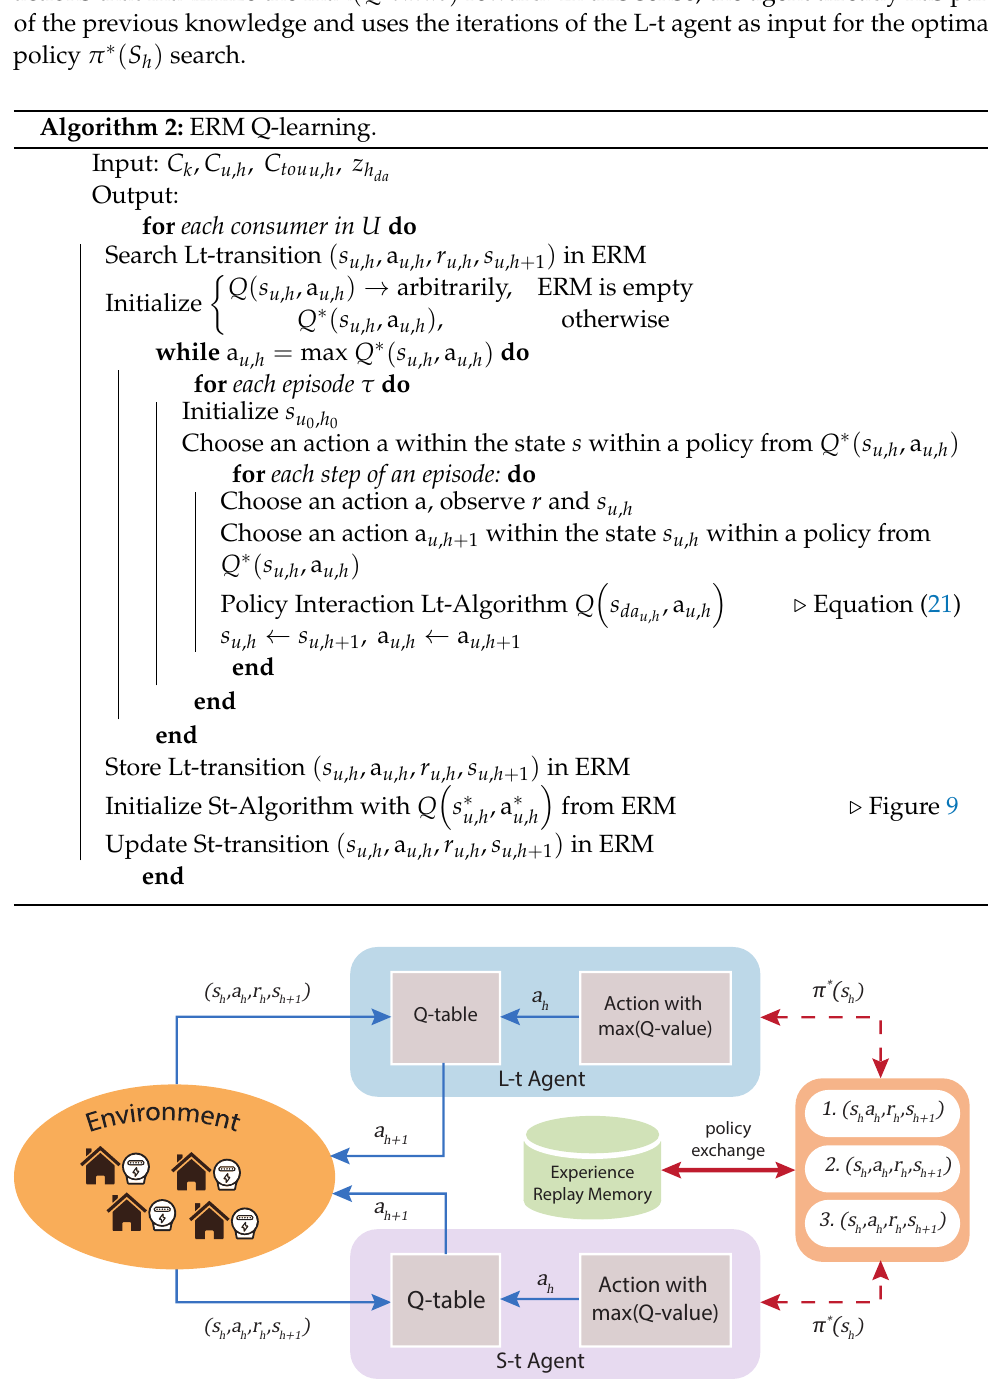
Figure 9. L-t and S-t